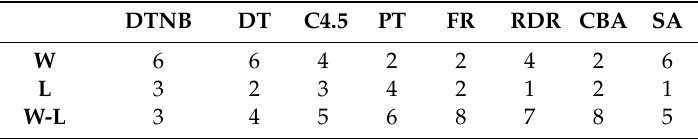
Table 7. Statistically significant wins / losses counts of J&B method on accuracy. DTNB